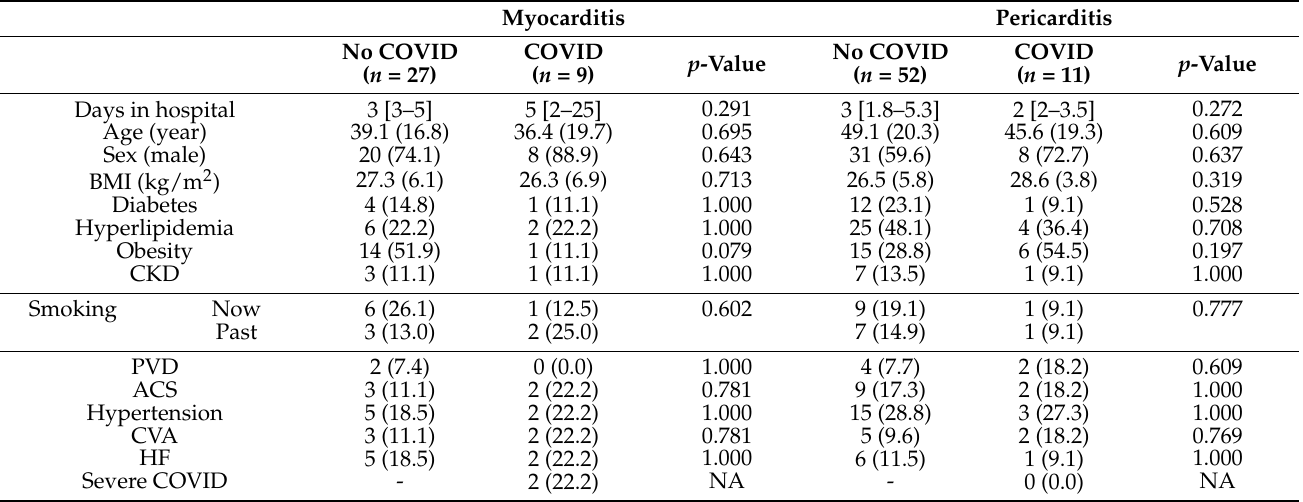
Table 2. Baseline characteristics of patients with myocarditis and pericarditis patients in the COVID and no COVID